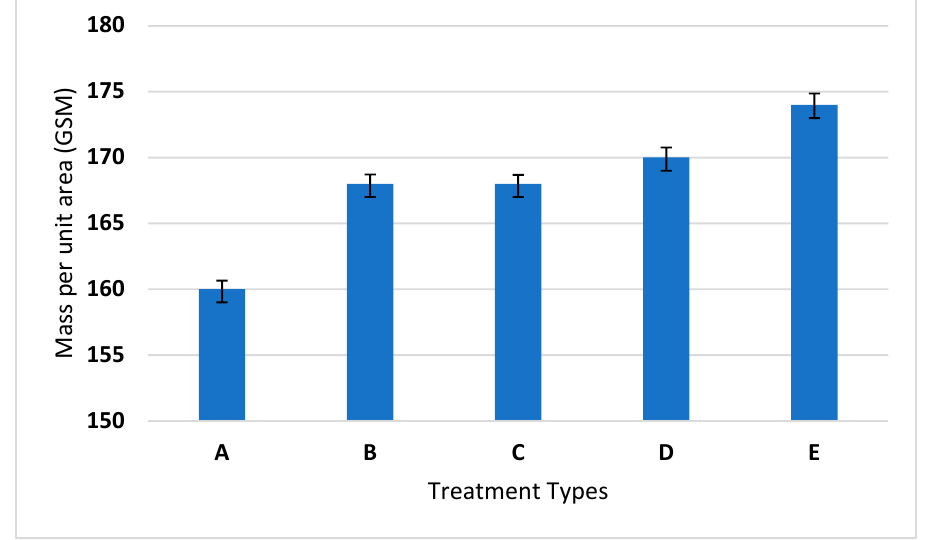
Table 3. Effect of finishes treatments on the mass per unit area (GSM) .